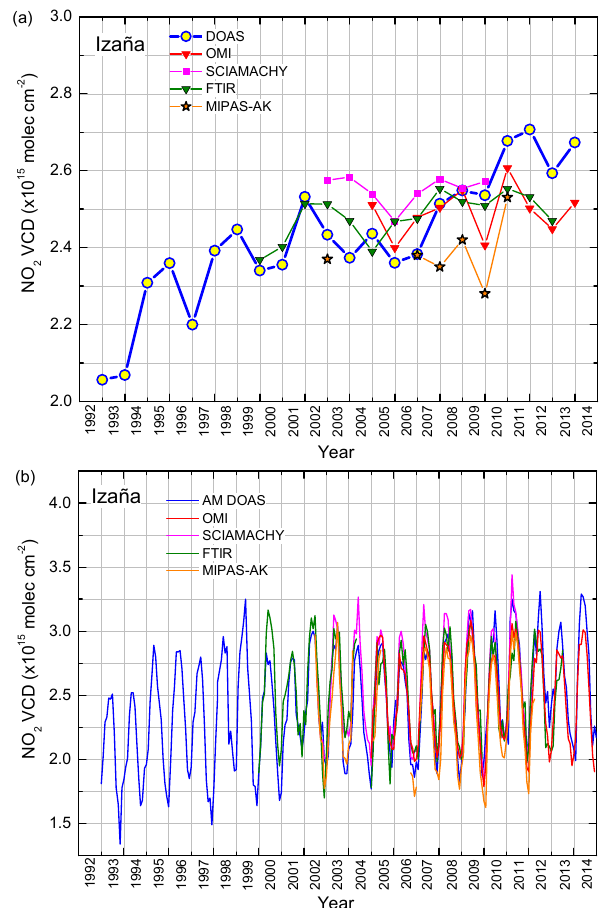
Figure 10. NO 2 VCD annual means at Izaña from the available datasets (a) obtained as monthly averages (b)